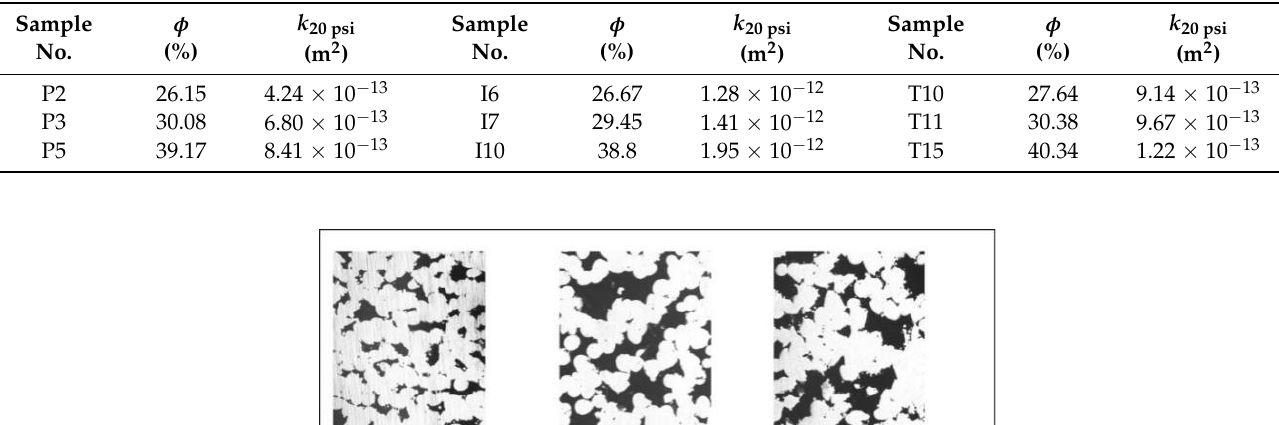
Table 6. Porosity and air permeability of 17-4 PH (P), Inconel 718 (I) and Ti-6Al-4V ELI (T) cellular parts.